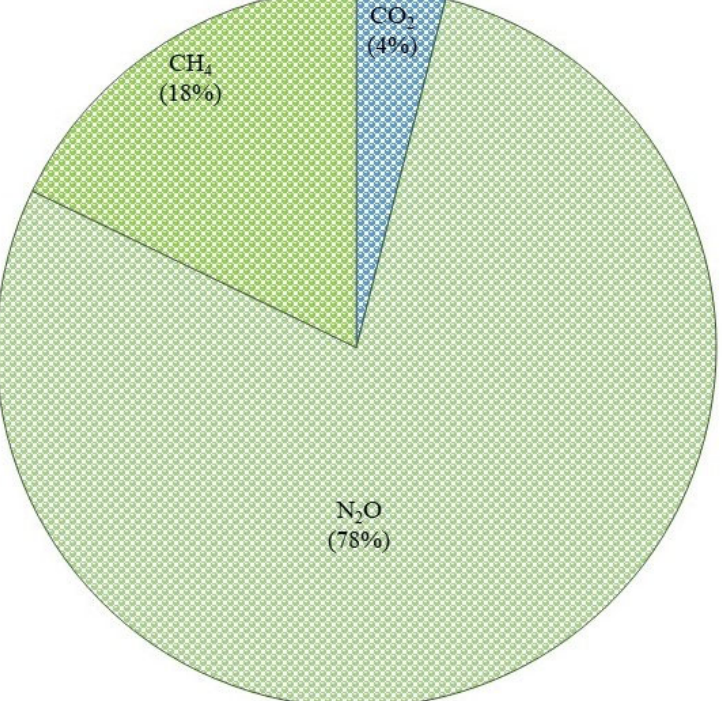
Figure 6. Percent contribution in global warming potential (GWP) originated from different GHGs under contrast tillage and irrigation